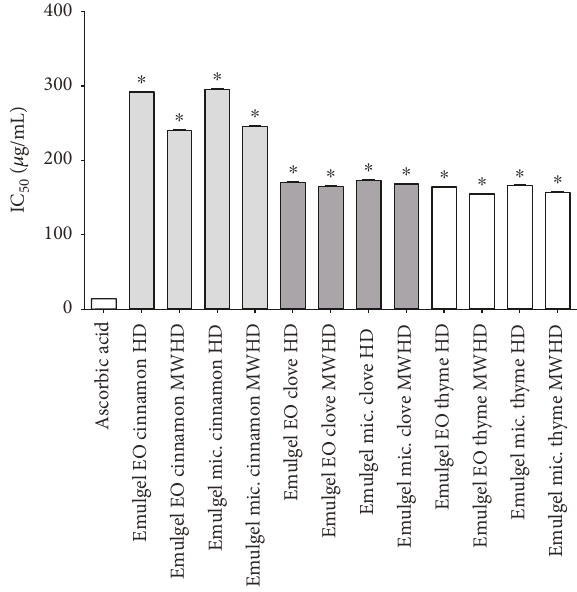
Figure 16: IC of the EO without and with microcapsule emulgels 50 evaluated by the DPPH method. ∗ Signi fi cant di ff erences compared to positive control p > 0 05 . IC corresponds to the value of the 50 essential oil concentration that stabilizes 50% of the free radical. Lower values indicate greater antioxidant activity.